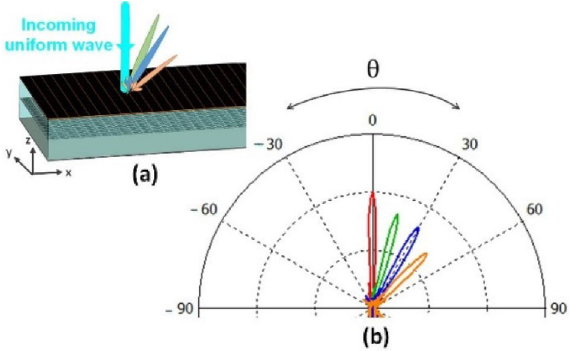
Figure 11. ( a ) Schematic of the proposed reflectarray forgenerating reconfigurable pencil-beams. ( b )Simulation results for the radiation pattern at ϕ = 0 ◦ .